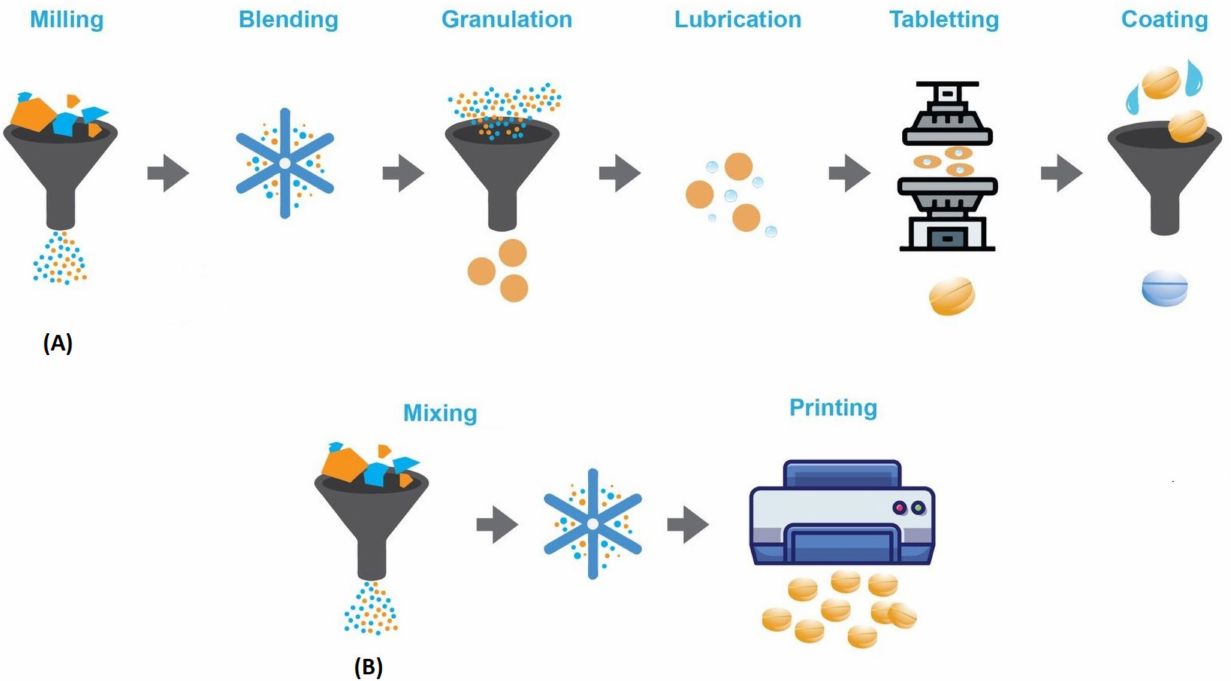
Figure 2. Traditional tablet manufacturing process ( A ) vs. 3D-printing manufacturing process ( B